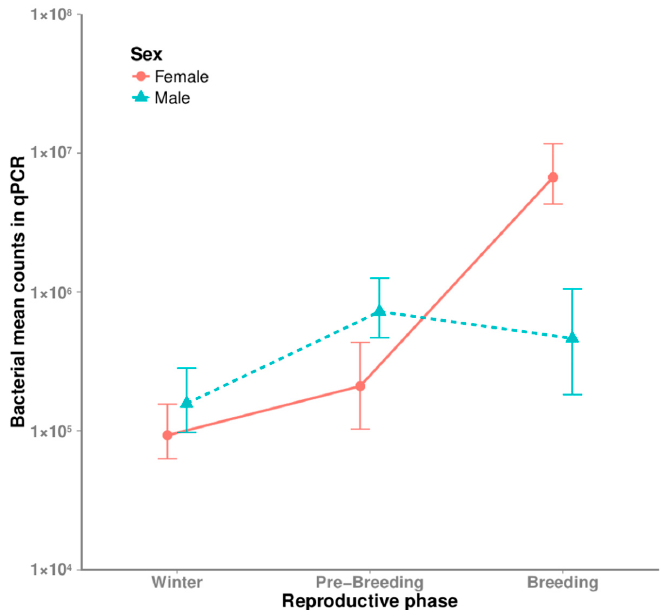
Figure 3. Interaction plot showing quantitative polymerase chain reaction (qPCR) results for bacterial counts per microliter of uropygial secretion. Bacterial density mean and standard deviation are represented for different reproductive phases of females (winter N = 2, pre-breeding N = 5, breeding N = 5) and males (winter N = 2, pre-breeding N = 5, breeding N = 5).